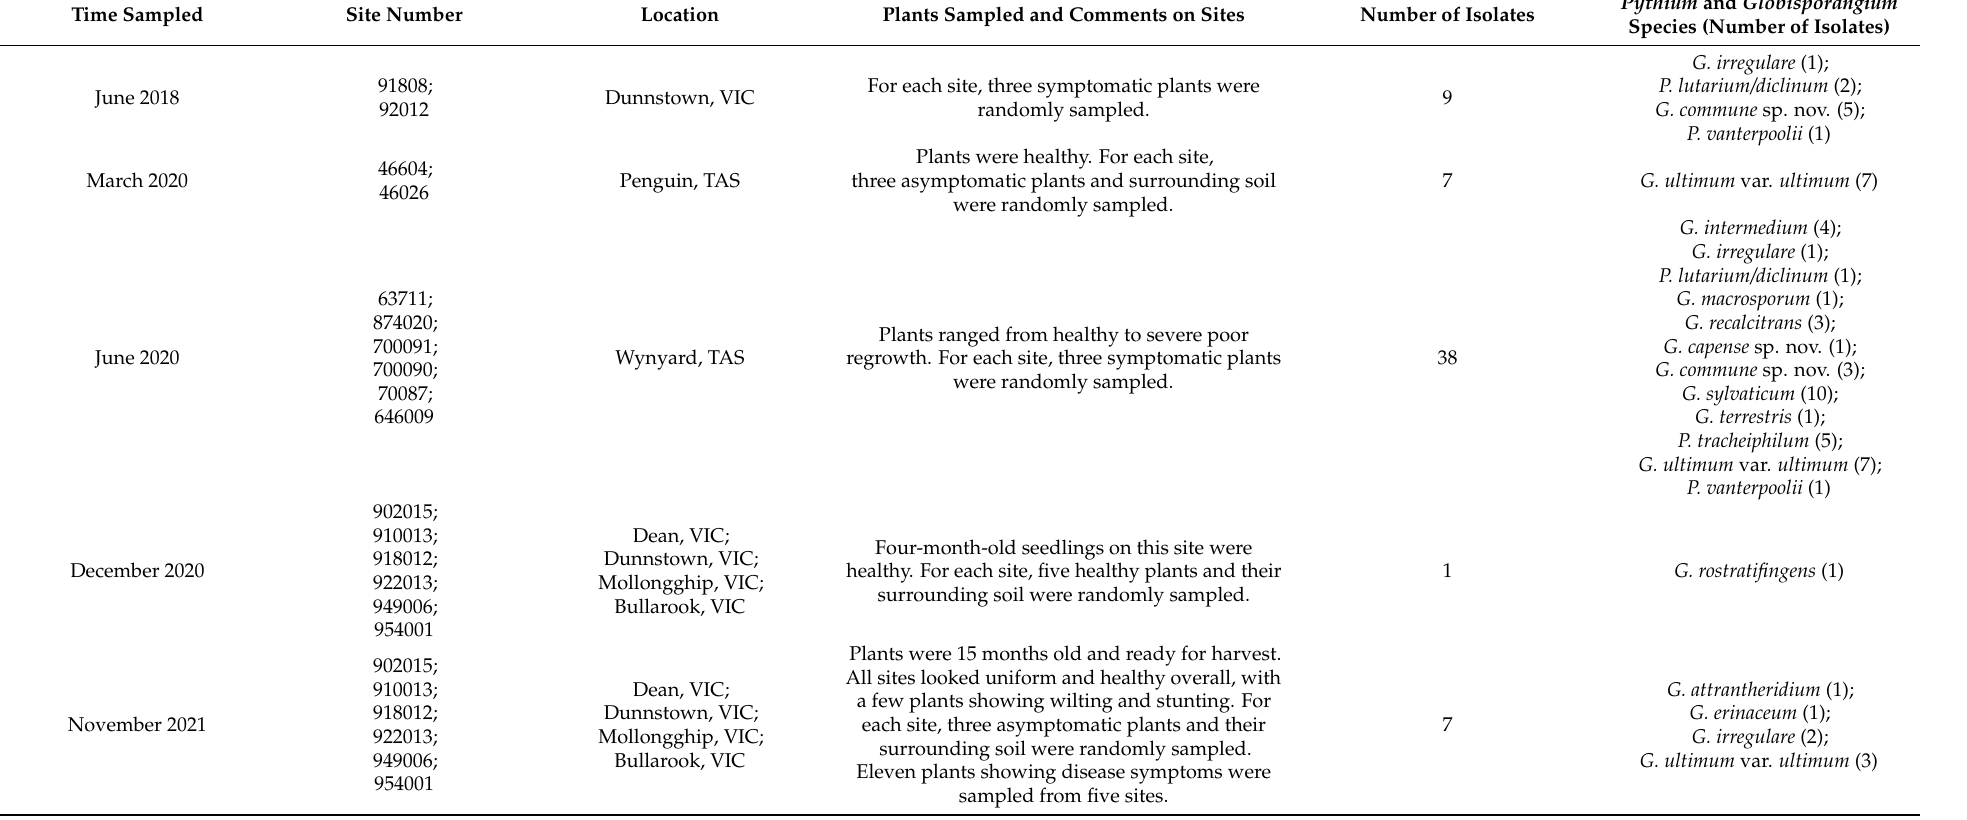
Table 2. Pythium and Globisporangium spp. isolated from the surveyed pyrethrum